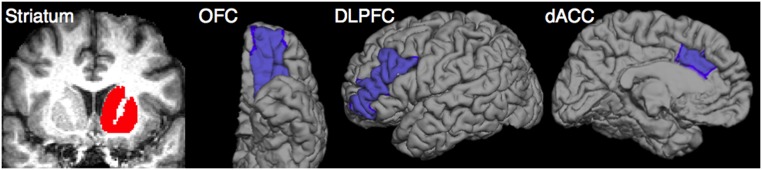
The striatum and 3 frontal ROIs (OFC, DLFPC, and dACC) in the left hemisphere.